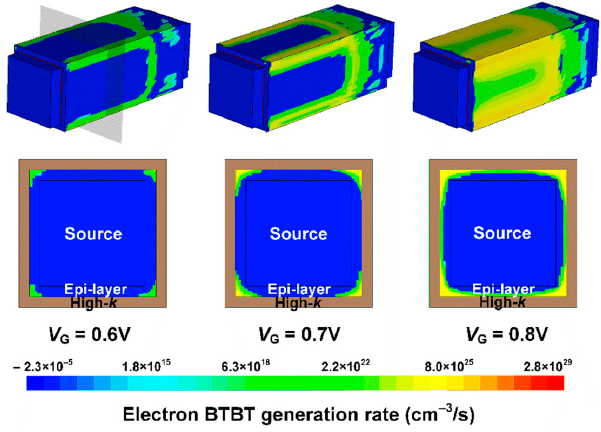
Figure 3. 3D and 2D contour plots of electron band-to-band tunneling (BTBT) generation rates of gate-normal NWTFETs at V G = 0.6V, 0.7V, and 0.8V at V D = 0.5V.